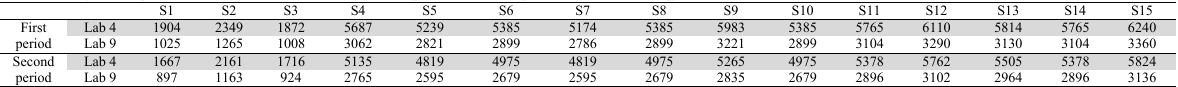
Quantity of gathered bloods in each processing lab at each period under each scenario S1 S2